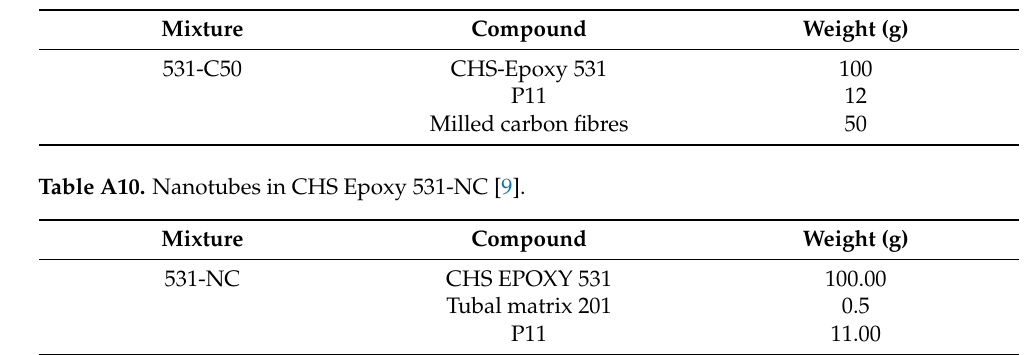
Table A9. Carbon fibres in CHS Epoxy 531, 50 phr [9].